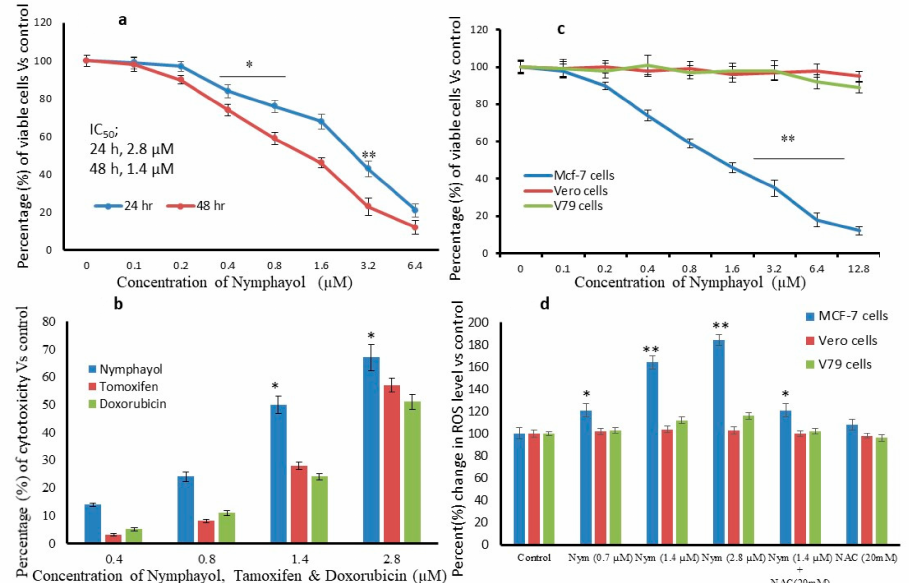
Figure 2. Cytotoxic e ff ect of nymphayol on MCF-7 cells after 24 h and 48 h ( a ); ( b ) shows the comparative cytotoxic e ff ect of nymphayol, tamoxifen, and fluorouracil after 48 h; ( c ) shows the cell specific cytotoxic e ff ect between MCF-7 and normal (Vero and V79) cells after 48 h; ( d ) shows the comparative reactive oxygen species (ROS) production levels in vehicle control dimethyl sulfoxide (DMSO) and nymphayol treated MCF-7, Vero and V79 cells after 48 h. Data are expressed as the mean ± SD (n = 6). * p ≤ 0.01 vs. vehicle control, ** p ≤ 0.001 vs. vehicle